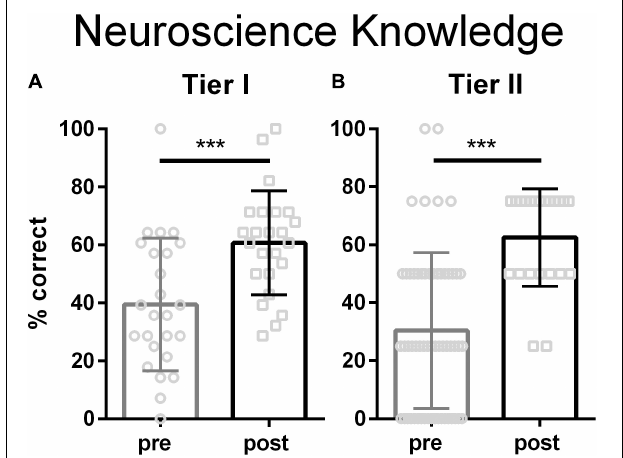
FIGURE 1 | Knowledge of neuroscience for teachers attending Tier 1 (A) and Tier II (B) . Tier I teachers took a 13 question multiple choice test (MacNabb et al., 2006b). Tier II teachers took a 4 question multiple choice test. Both Tier I and Tier II teachers significantly increased their knowledge of the neurobiology of learning and memory (Tier I, p = 0.0007, Cohen’s d = 1.0; Tier II, p < 0.0001, Cohen’s d = 1.3; 2 tailed t- tests). Bars are mean ± stdev; Tier I N = 25 pre, 24 post, Tier II N = 60 pre, 22 post. *** represents p <